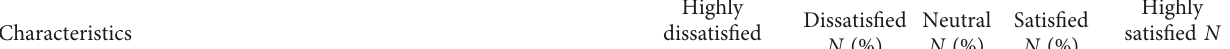
Table 4: Level of client satisfaction with different component of health service provider at the OPD of DURH, Ethiopia, 2021 ( n � 412).